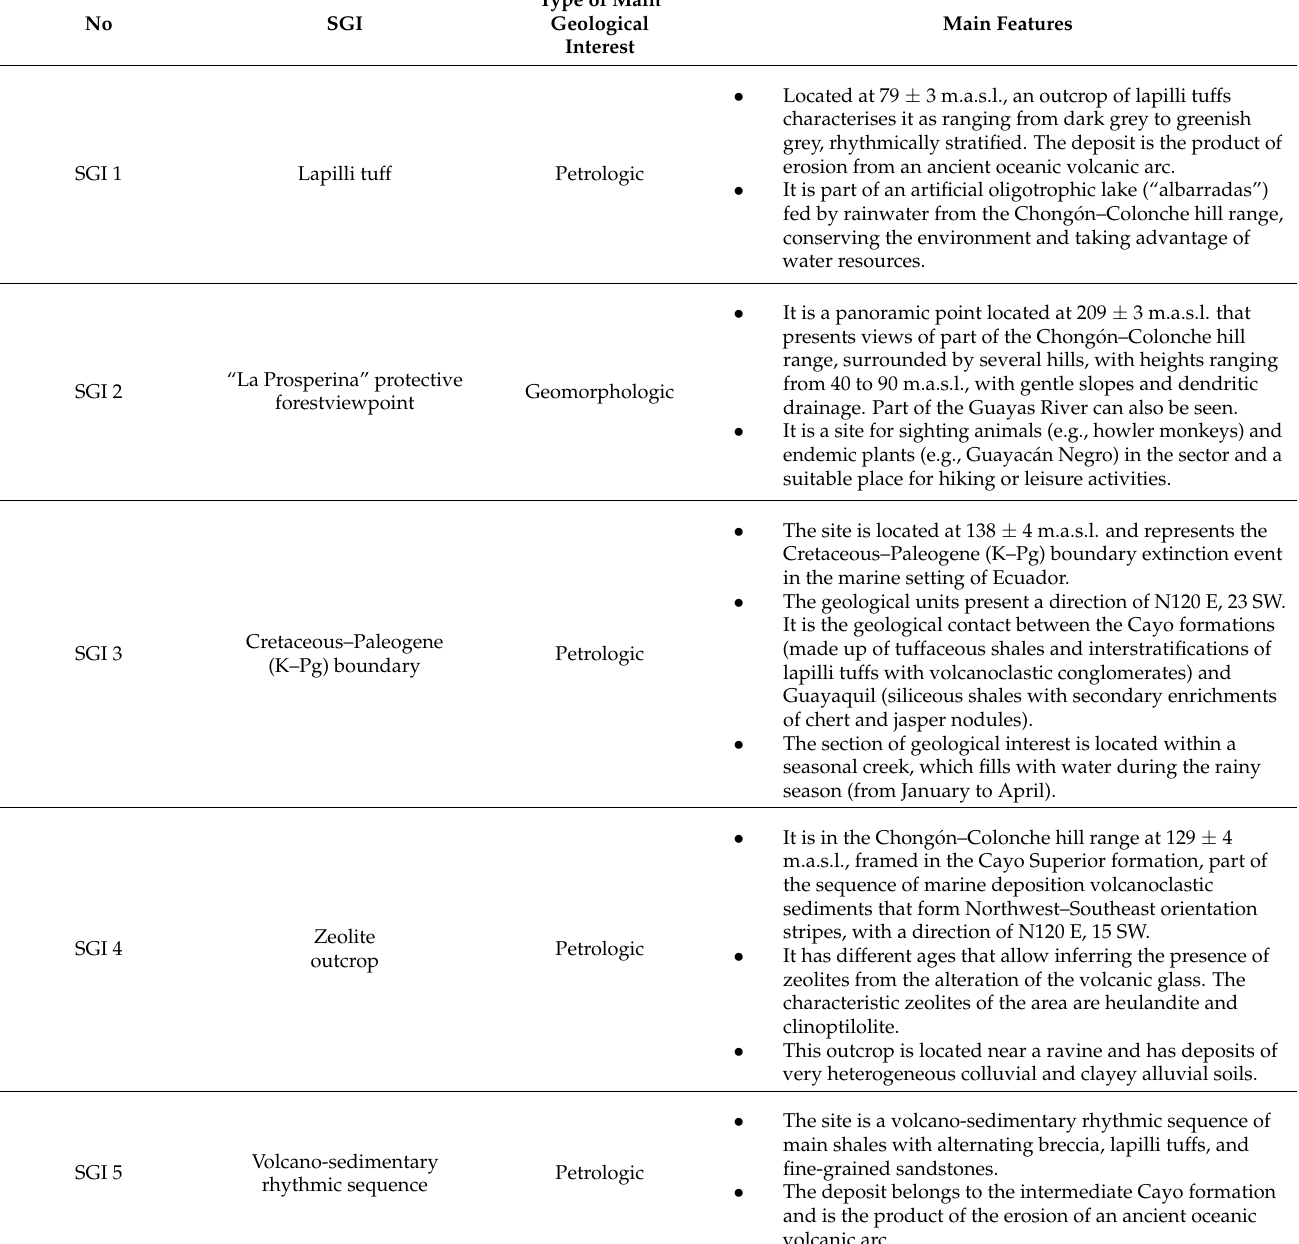
Table 5. List of five sites of geological interest within the university